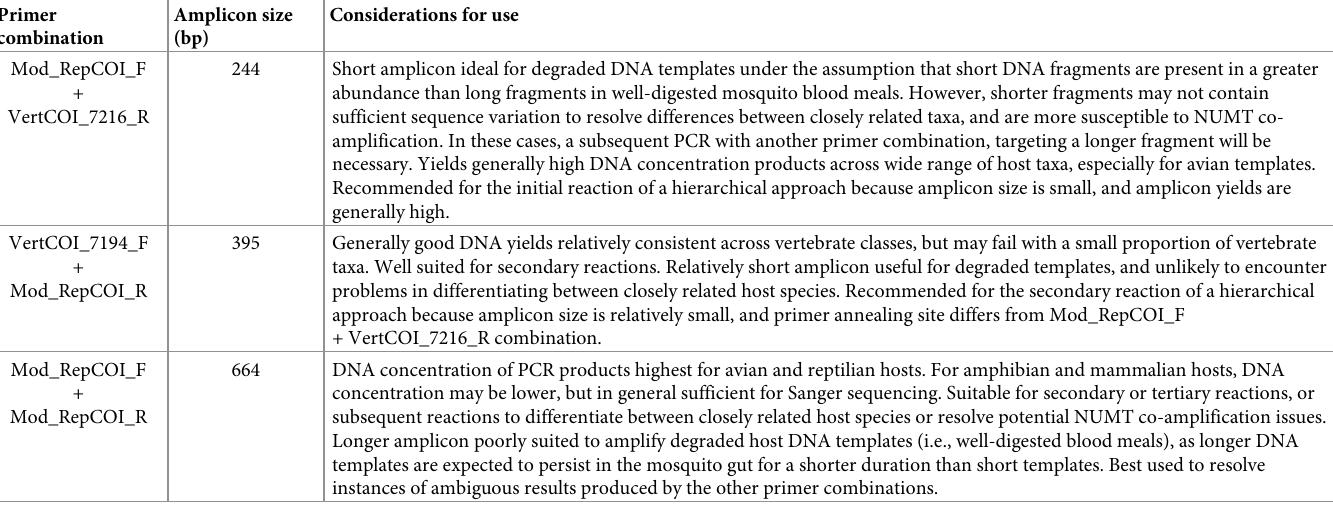
Table 6. Summary of results and factors for consideration in designing a hierarchical approach to PCR using three combinations of new vertebrate-specific cyto- chrome c oxidasesubunit I